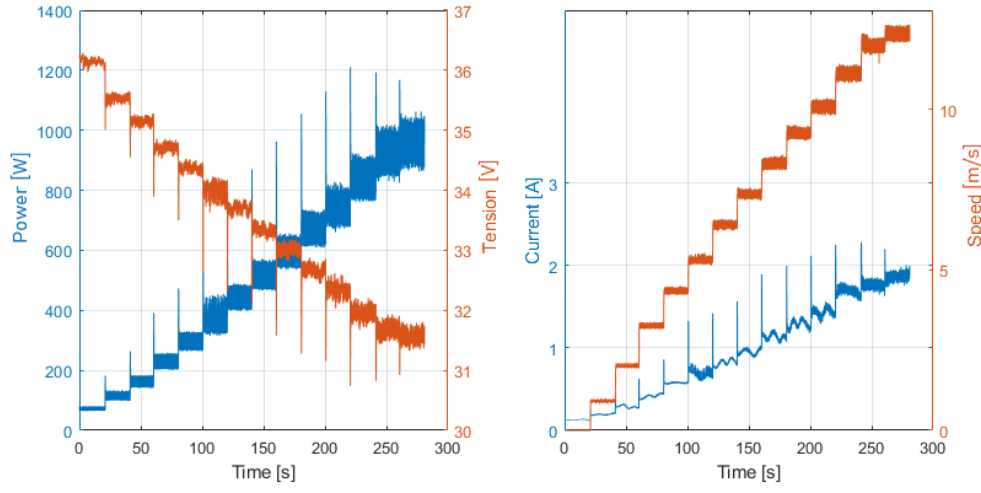
Figure 11. Speed vs. Power.